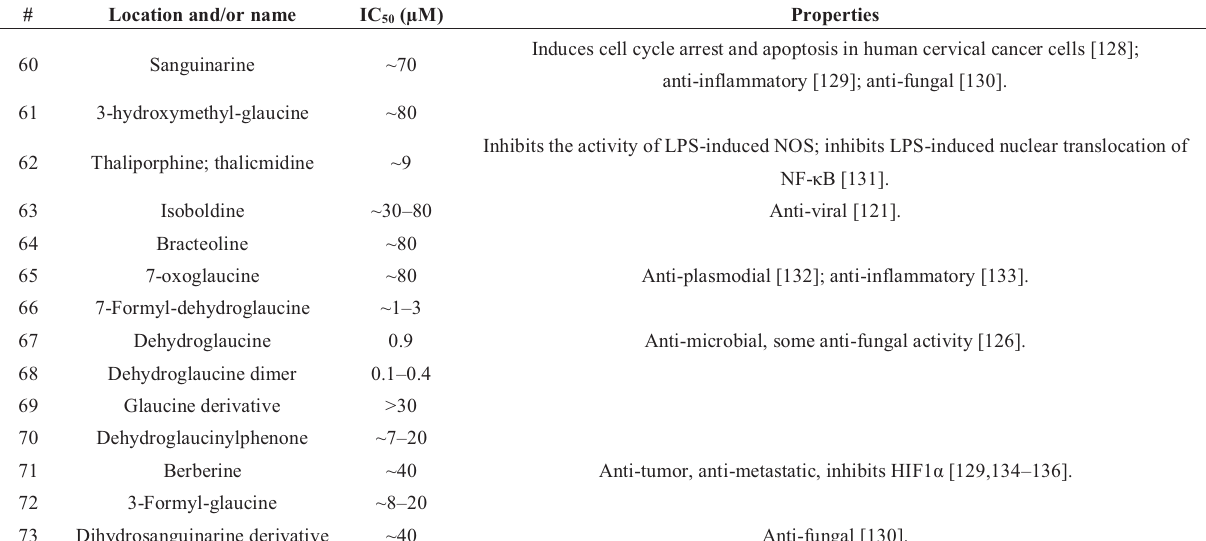
Table 7. Benzylisoquinoline Alkaloids.